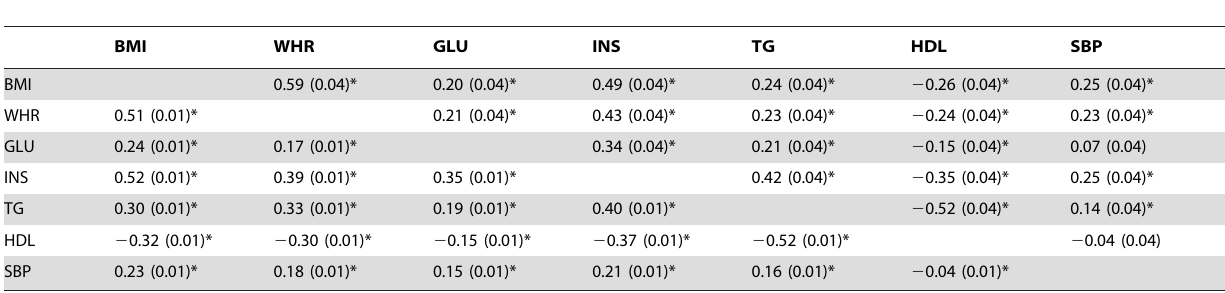
Table 4. Phenotypic correlation coefficients between MetS traits in the ARIC